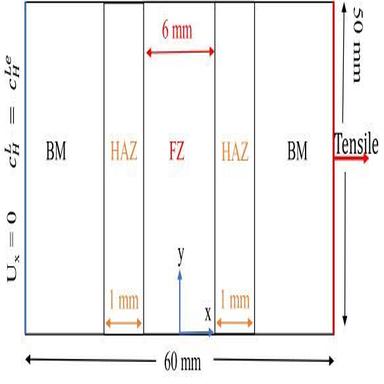
Schematic geometry and boundary conditions.